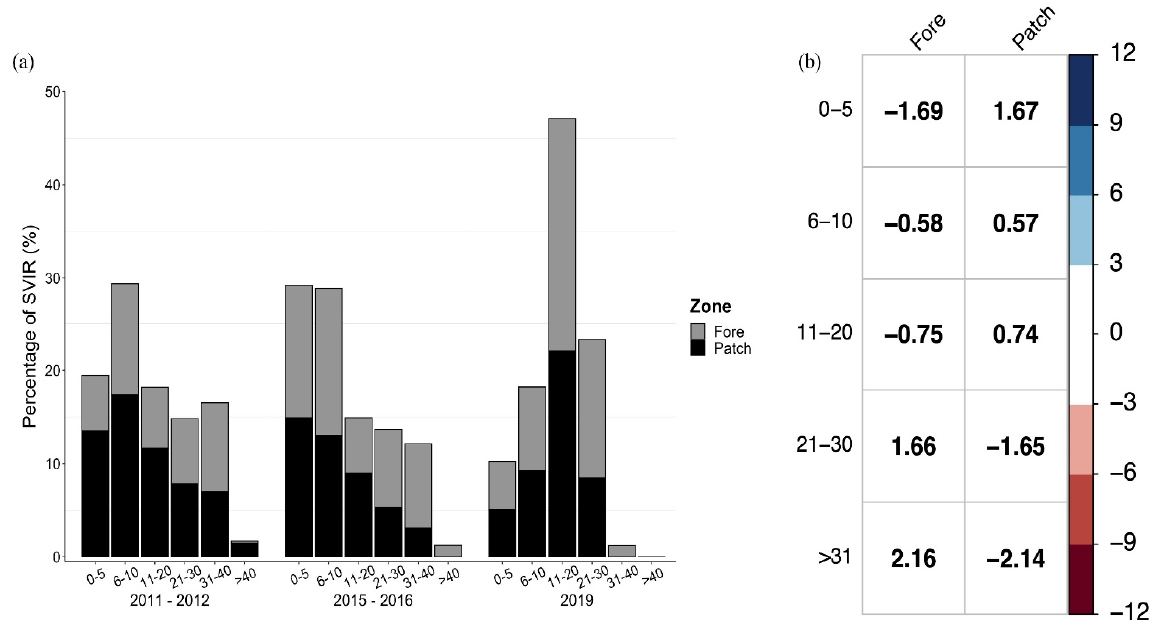
Figure 8. ( a ) Size frequency distribution showing the percentage of all parrotfish in different size classes across each survey period by reef zone and ( b ) corrplot illustrating the Pearson residuals for each size class contributing to the global chi-square statistic. The residual cutoff used to indicate a significant deviance from the expected standardized residuals of the global chi-square test is set at ±2.807. Color indicates the sign and magnitude of the residuals as follows: blue is significantly pos- itive, red is significantly negative and white is non-significant.